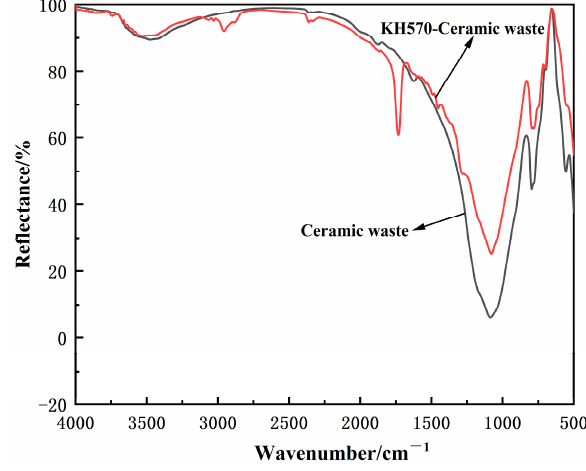
Figure 4. FTIR spectra of ceramic waste before and after modification by using the silane coupling agent.